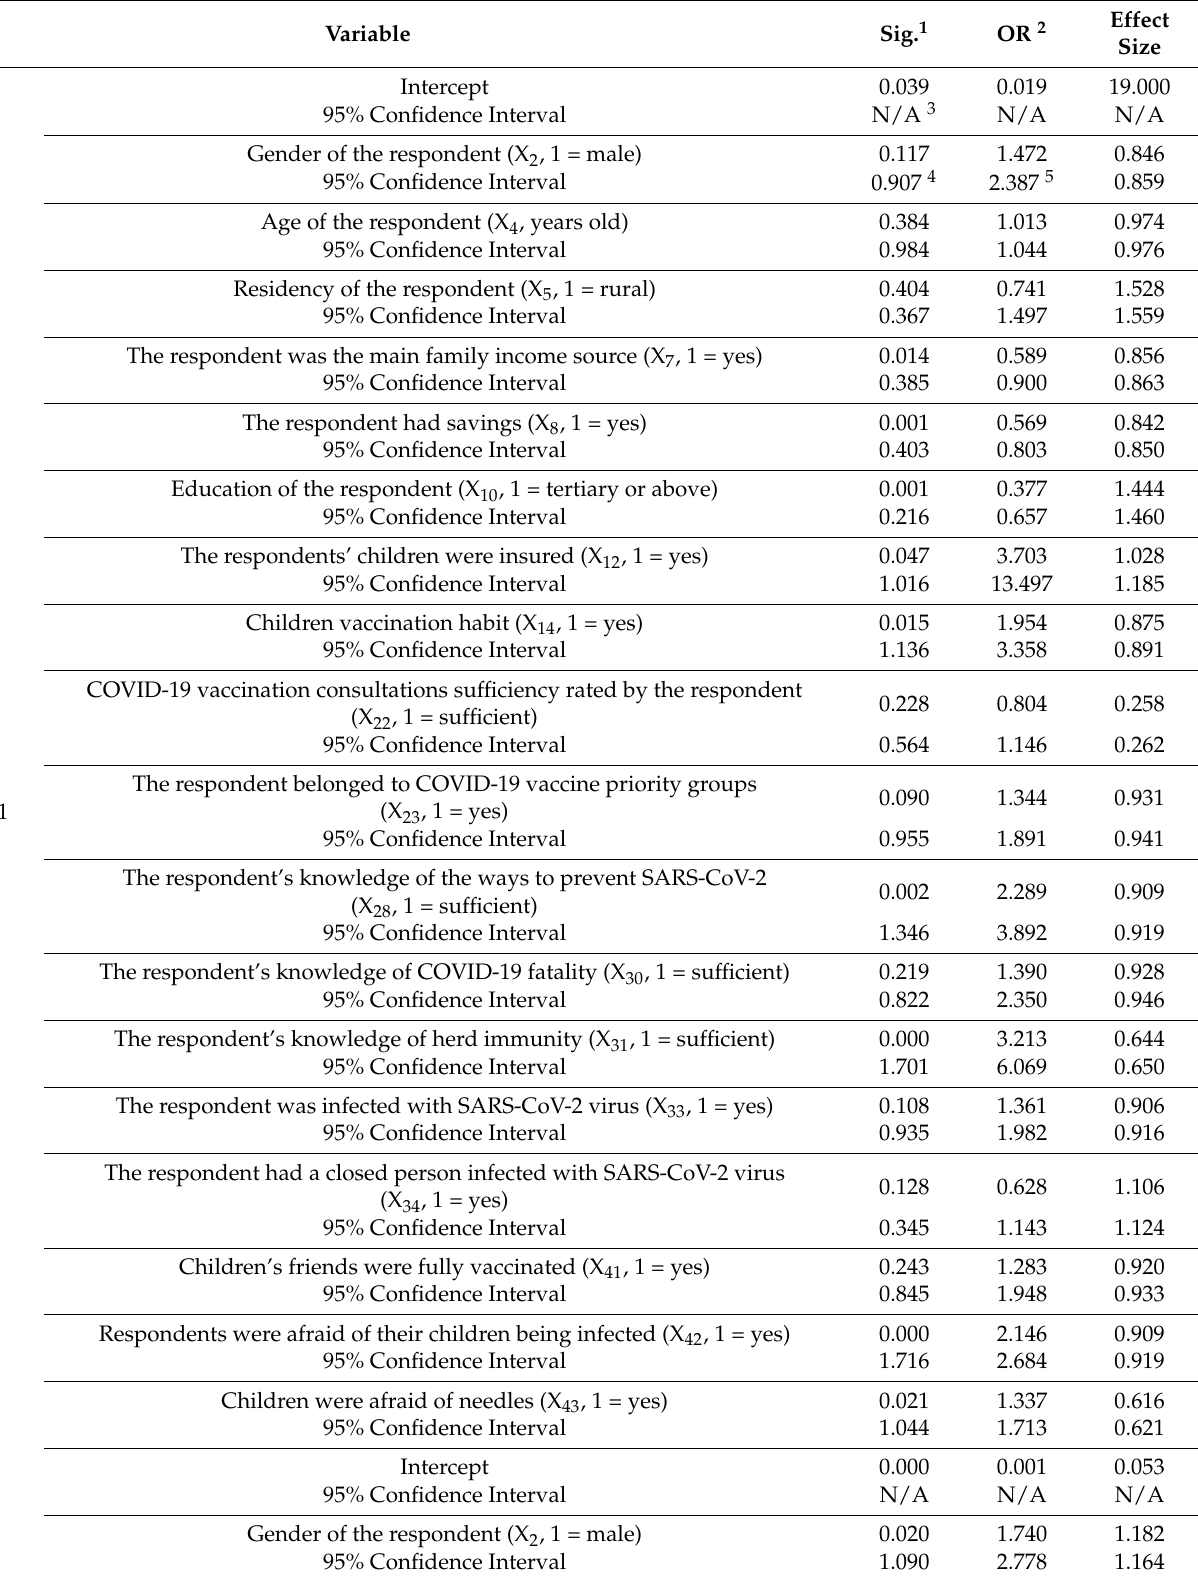
Table 3. The association between the willingness of parents to vaccinate their children aged from 5 to under 12 years and selected influential